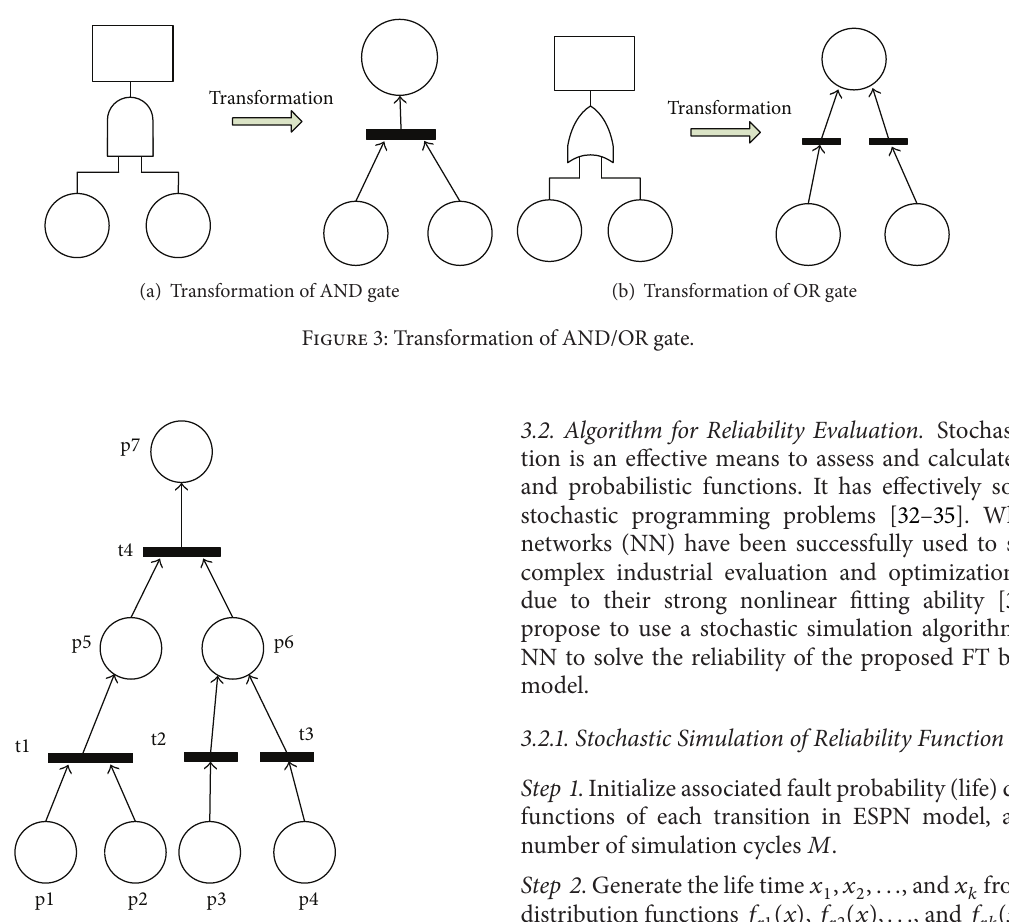
Figure 4: ESPN model for reliability analysis of a mechanical